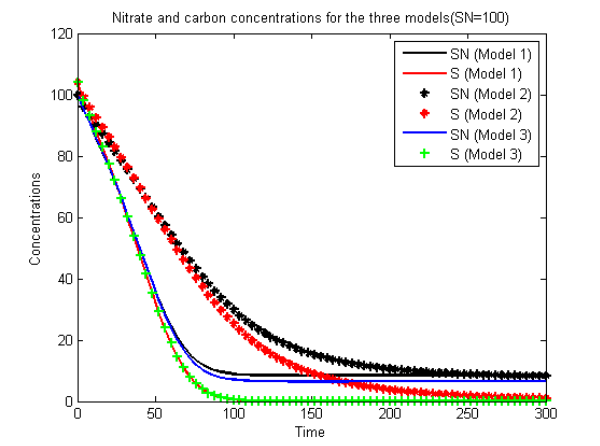
Figure 9. Concentrations of carbon and nitrates for the three models at point (2.9, 0.8) for S in